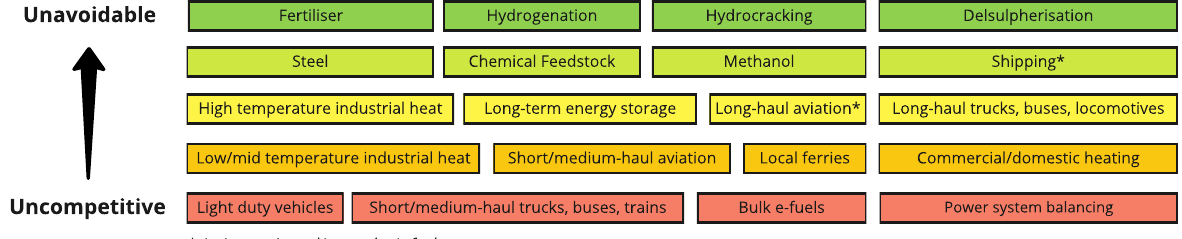
Fig. 4 Example of the spectrum of potential hydrogen applications spanning from unavoidable to uncompetitive. Author supplied; concept credit: Liebreich Associates